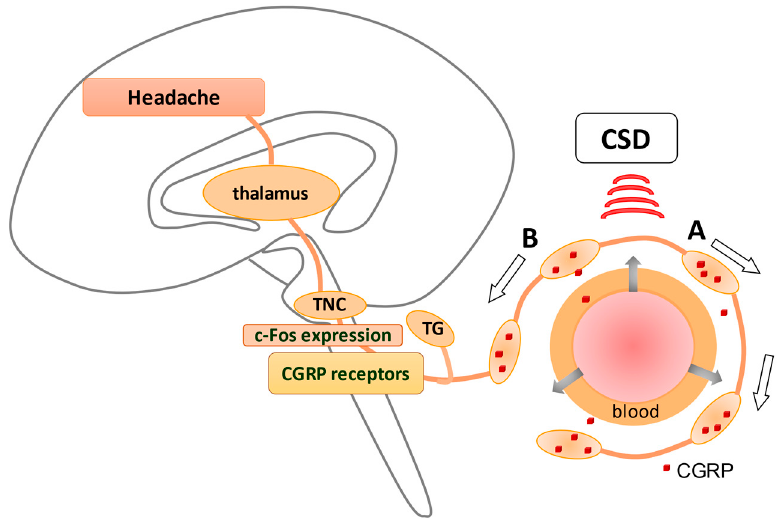
Figure 1. CGRP and the trigemino-vascular system in migraine.